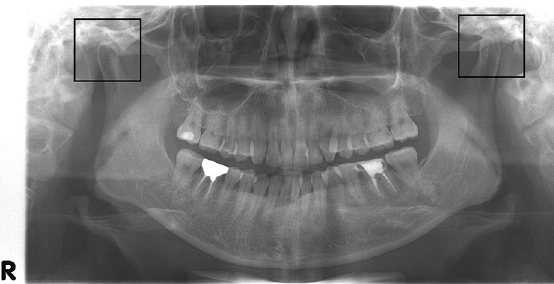
Figure 2. Result of ROI extraction, 300 × 300